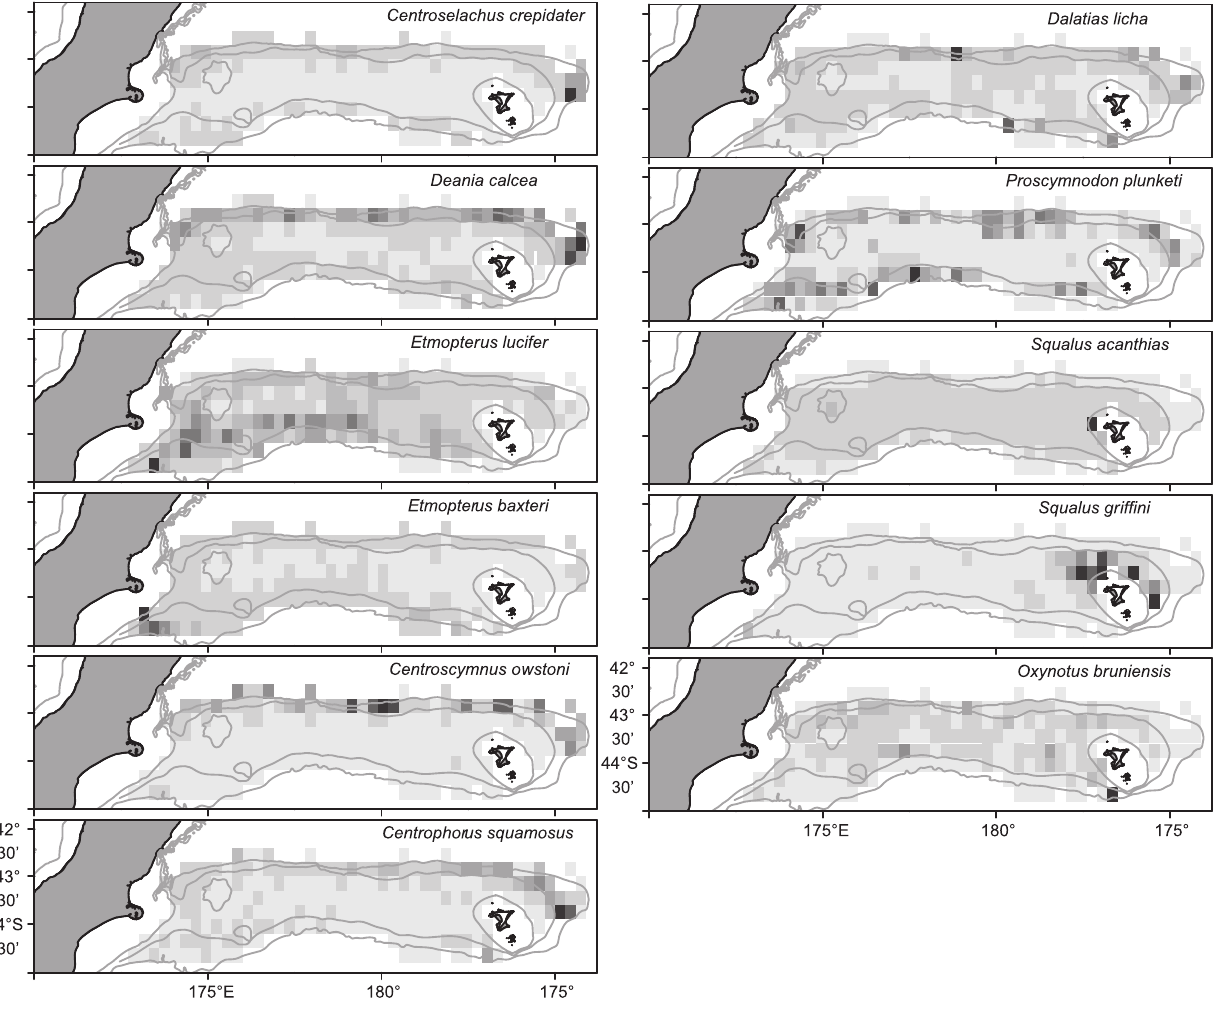
Figure 3. Catch rate (median kg km 2 2 ) of squaliforme sharks on Chatham Rise in 0.3 6 latitude and longitude cells. Cells shaded in the lightest grey were sampled but no catches of that species were made; cells shaded in successively darker grey had higher mean catch rates. Maximum mean catch rates: Centroselachus crepidater 686 kg km 2 2 ; Deania calcea 473 kg km 2 2 ; Etmopterus lucifer 12 kg km 2 2 ; Etmopterus baxteri 560 kg km 2 2 ; Centroscymnus owstoni 98 kg km 2 2 ; Centrophorus squamosus 100 kg km 2 2 ; Dalatias licha 52 kg km 2 2 ; Proscymnodon plunketi 13 kg km 2 2 ; Squalus acanthias 4630 kg km 2 2 ; Squalus griffini 10 kg km 2 2 ; Oxynotus bruniensis 9 kg km 2 2 . Grey lines show the 200 m, 600 m, and 1000 m isobaths.